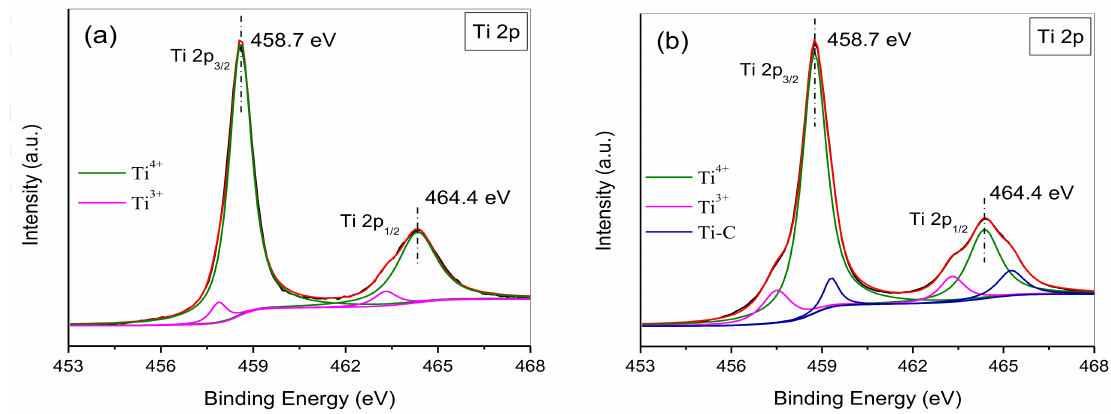
Figure 6. Ti 2p XPS spectra of ( a ) HTT/graphene-1.0%-mixed and ( b ) HTT/graphene-1.0% chemically bonded